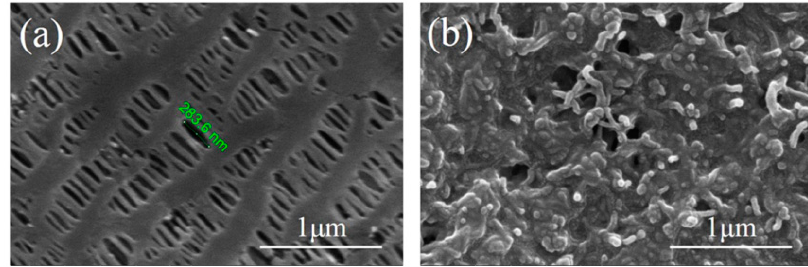
Figure 4. SEM images of ( a ) blank separator and ( b ) CNTs-coated separator.